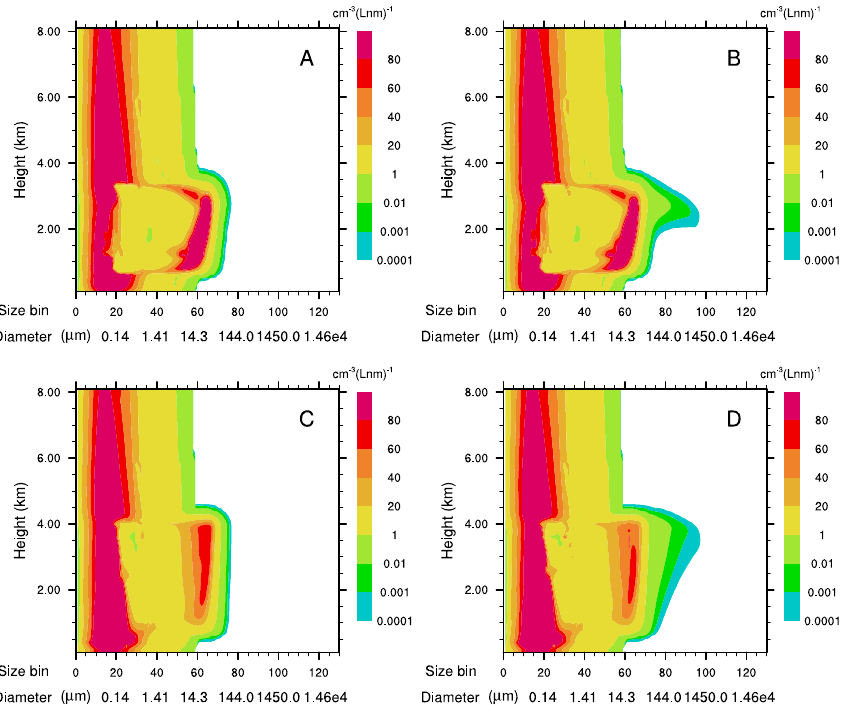
Fig. 3. Number distributions of unactivated ammonium sulfate aerosol particles and of water droplets as a function of height, natural logarithm of the water mass of the bin and natural logarithm of the aerosol mass of the bin f (Lnm water , Lnm aerosol , Z ) (Numbercm − 3 (Lnm water ) − 1 ) at 37 min in simulations with perturbation pressures (A, B) and at 31min in simulations with perturbation pressures omitted (C, D) . (A) and (C) Simulations of condensation and evaporation. (B) and (D) Simulations of condensation and evaporation as well as collision and